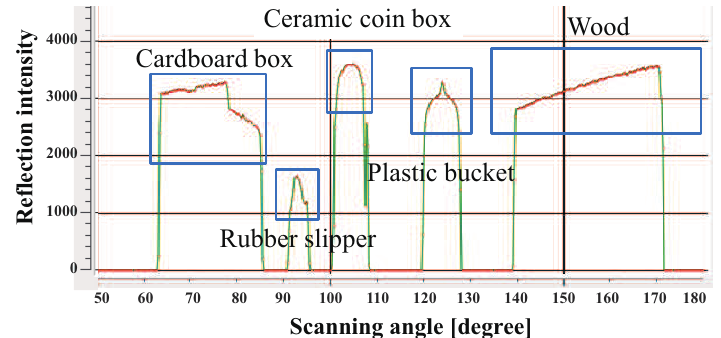
Figure 6. Reflection intensity value of each